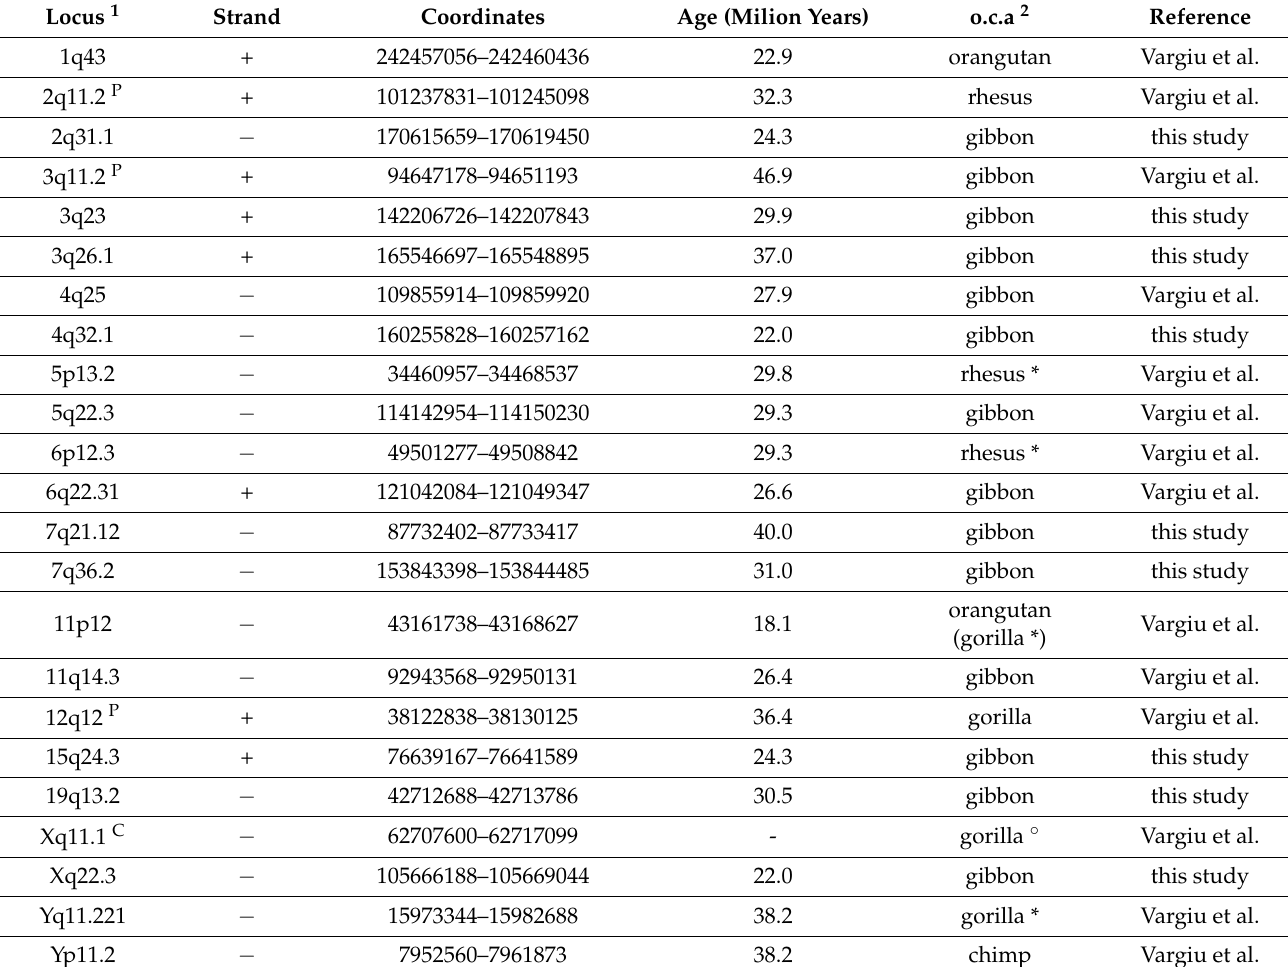
Table 1. HML7 proviral sequences identified in the human genome assembly